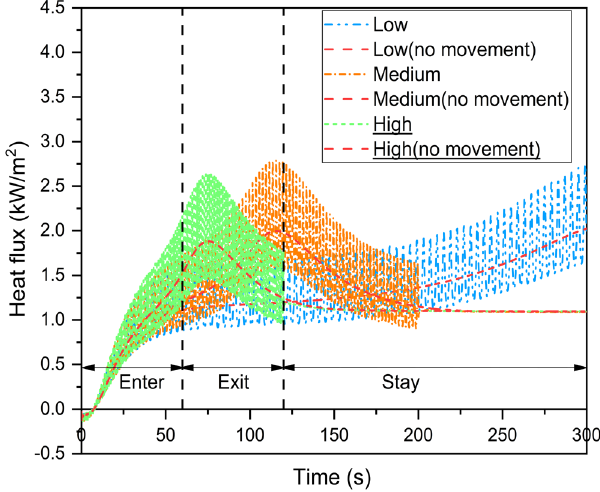
Figure 12. Effect of the human body movement speed on total heat flux through the microenviron- ment between the thermal liner back surface and the skin.